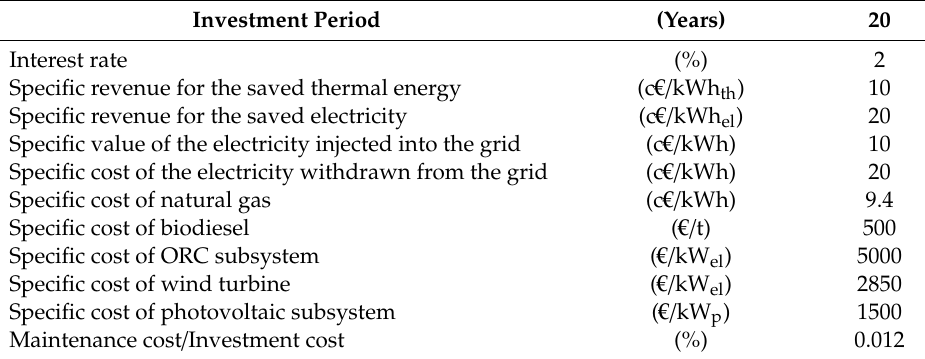
Table 4. Main assumptions for the economic